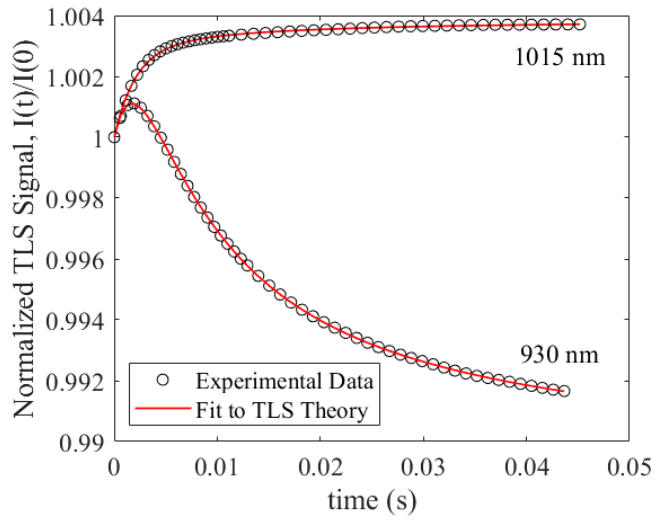
Figure 10. Normalized TLS signal versus time at 1015 nm and 930 nm, showing cooling and heating results in Yb:YLF, respectively. Black circles are the measured TLS signal, and red curves are best fits that account for population and thermal effects.